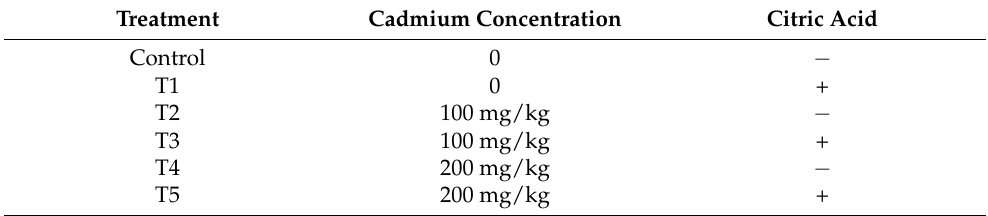
Table 2. Treatment